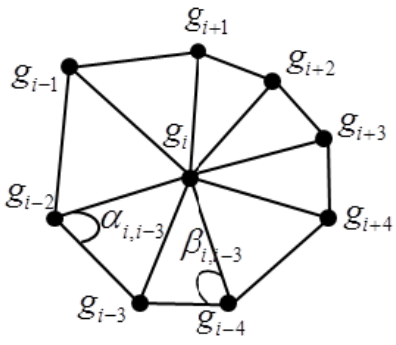
Fig. 1. Smooth ¯ltering of three-dimensional spiral CT dam- age